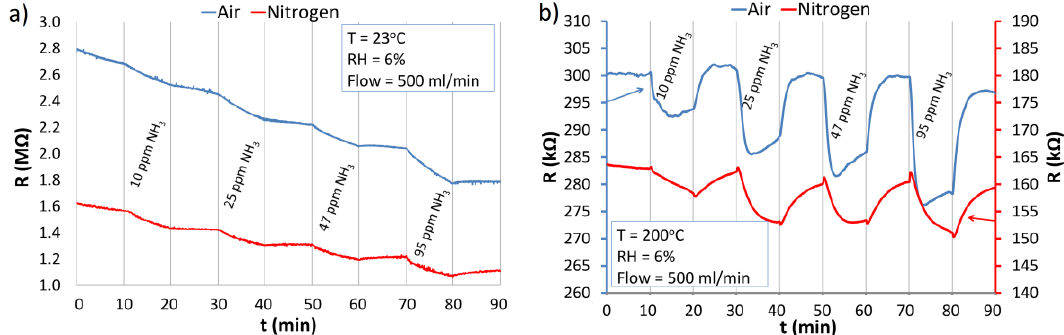
Figure 12. Reactions of the ZnO nanostructures with NH 3 in air and nitrogen atmospheres at: ( a ) RT; ( b ) 200 °C.